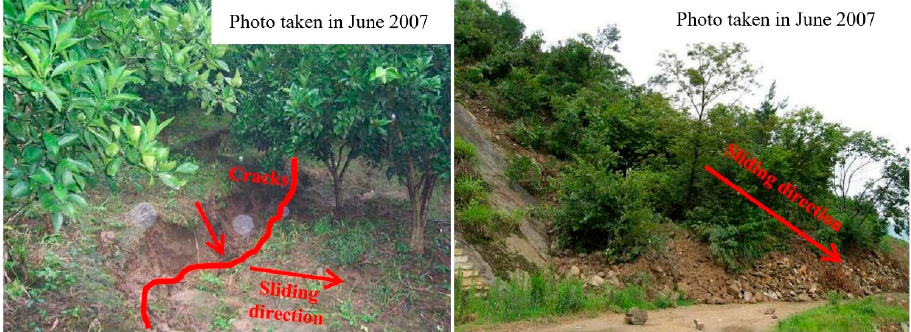
Figure 7. Macroscopic deformation of the Baishuihe landslide © 2022 Springer Nature [33].